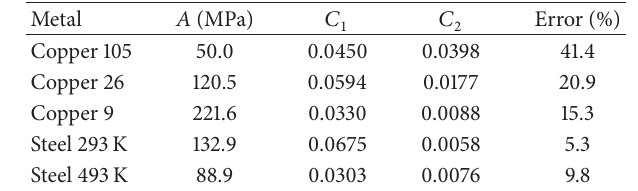
Table 3: Material constants and errors obtained by the Huh-Kang